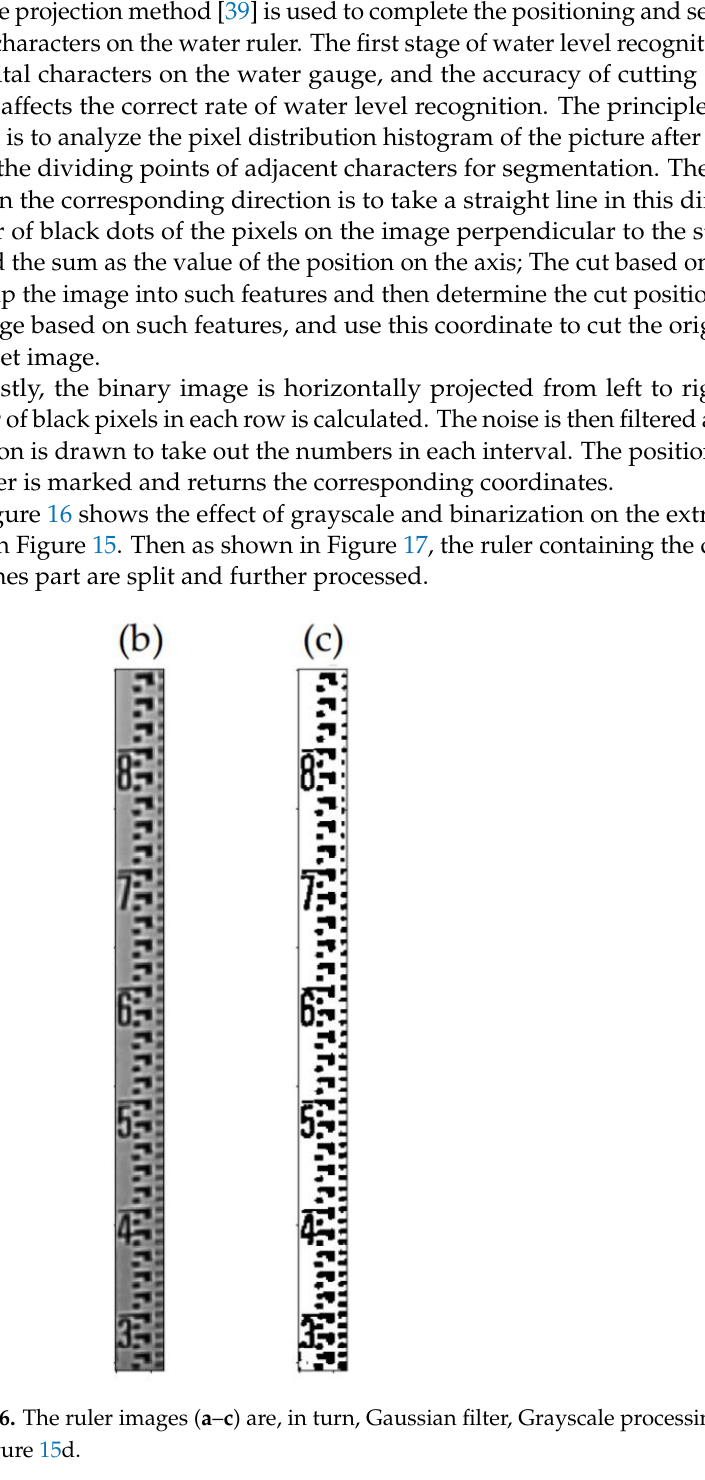
Figure 17. Further segmentation of characters and scale lines. ( a ) The image of the water ruler con- taining only one side of the array character area segmented from the image Figure 16c. ( b ) The image of the water ruler containing only one side of the scale lines area segmented from the image in Figure 16c. ( c ) The final four images ( c – f ) are obtained by morphological manipulation and projection from ( b ).